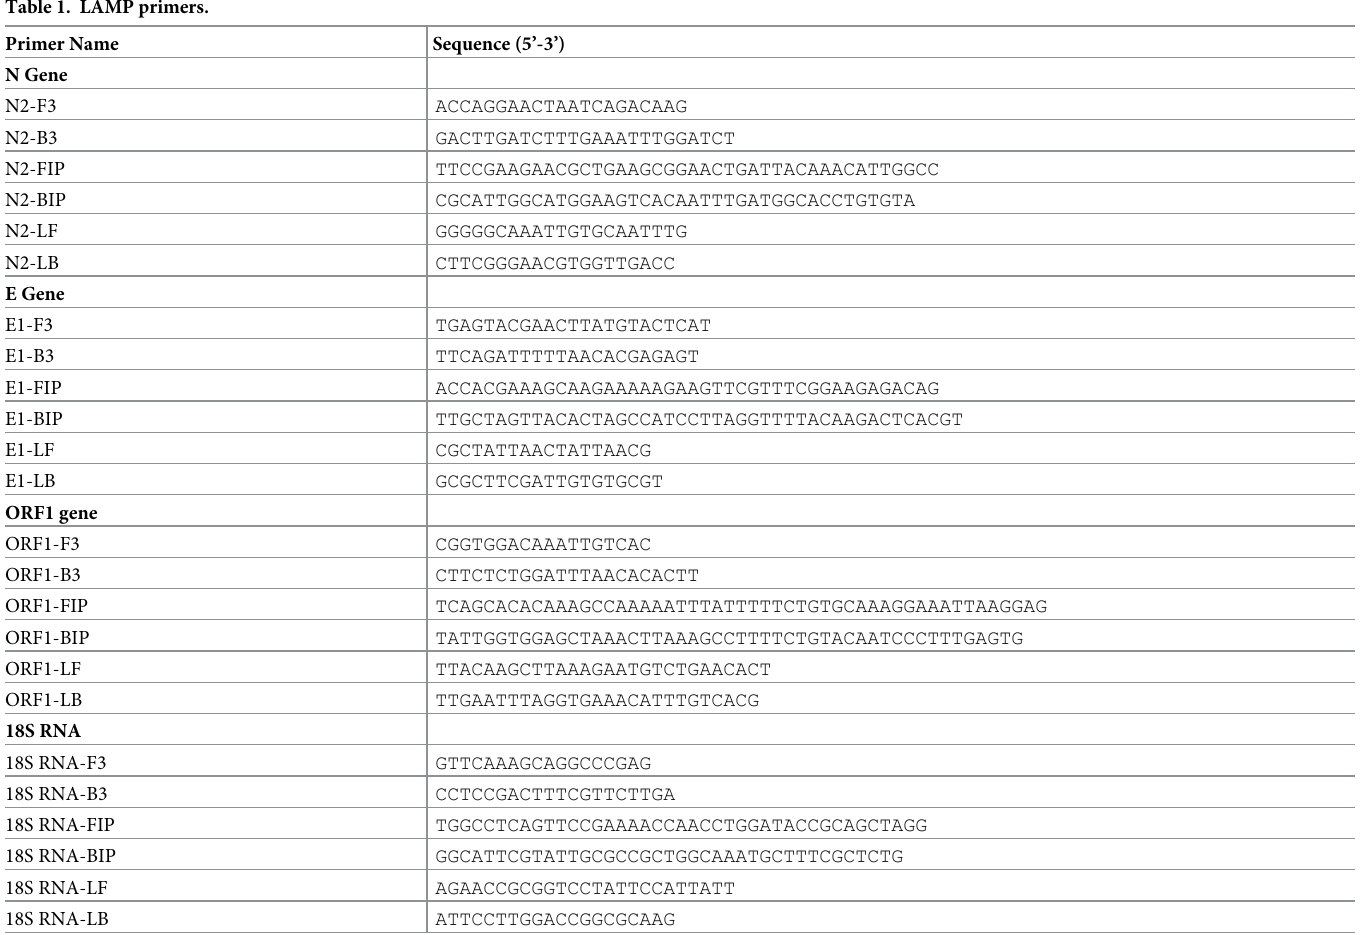
Table 1. LAMP primers.